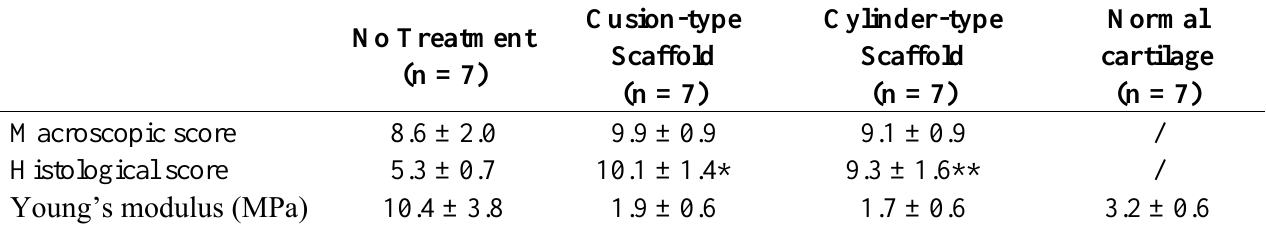
Table 6. Quantitative evaluations of reparative tissue at 12 weeks after operation